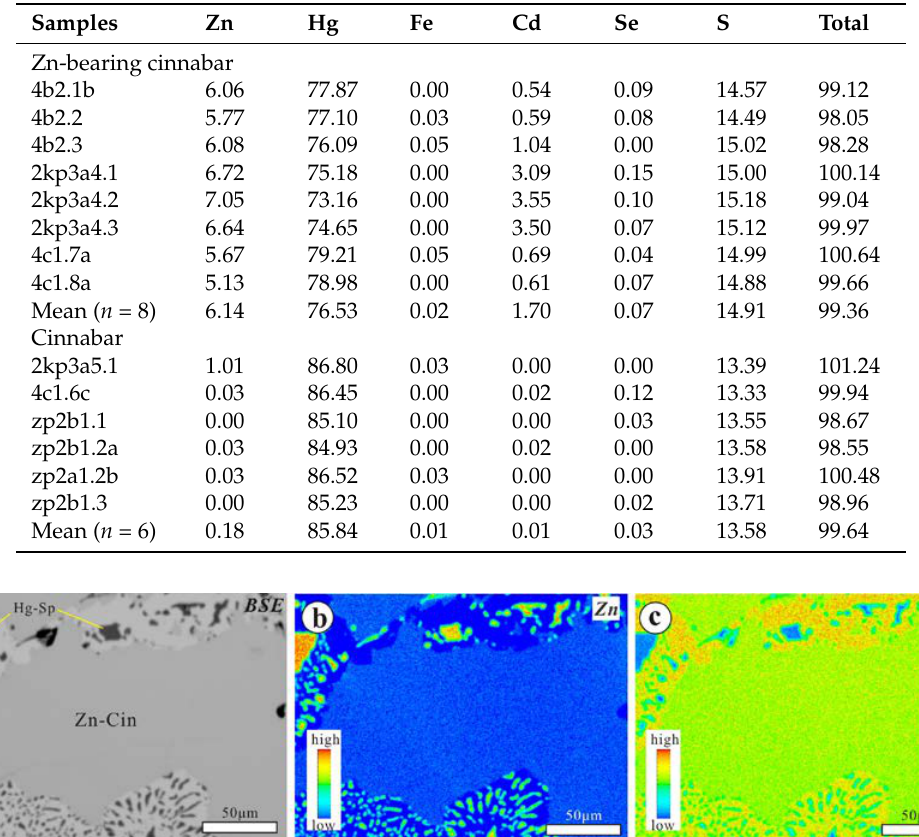
Table 2. EPMA data for Zn-bearing cinnabar and cinnabar from the Chashula deposit (wt %). Samples